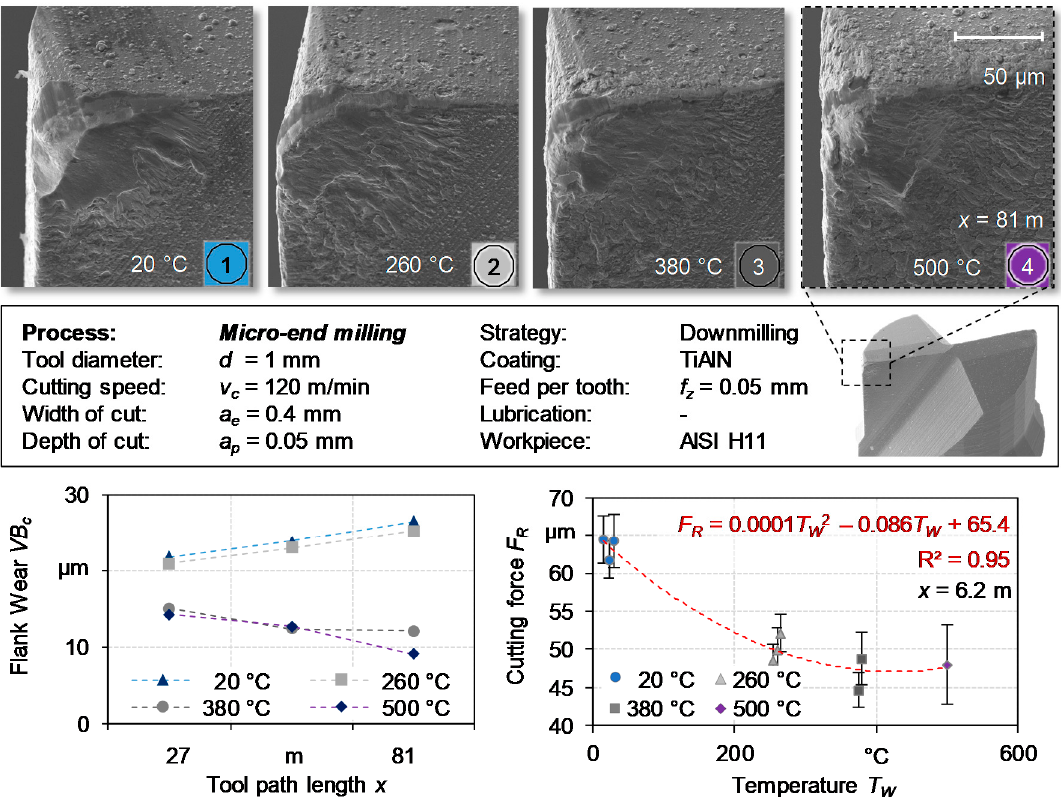
Figure 7. Cutting force and tool wear when thermally assisted micromilling a HWS, AISI H11.